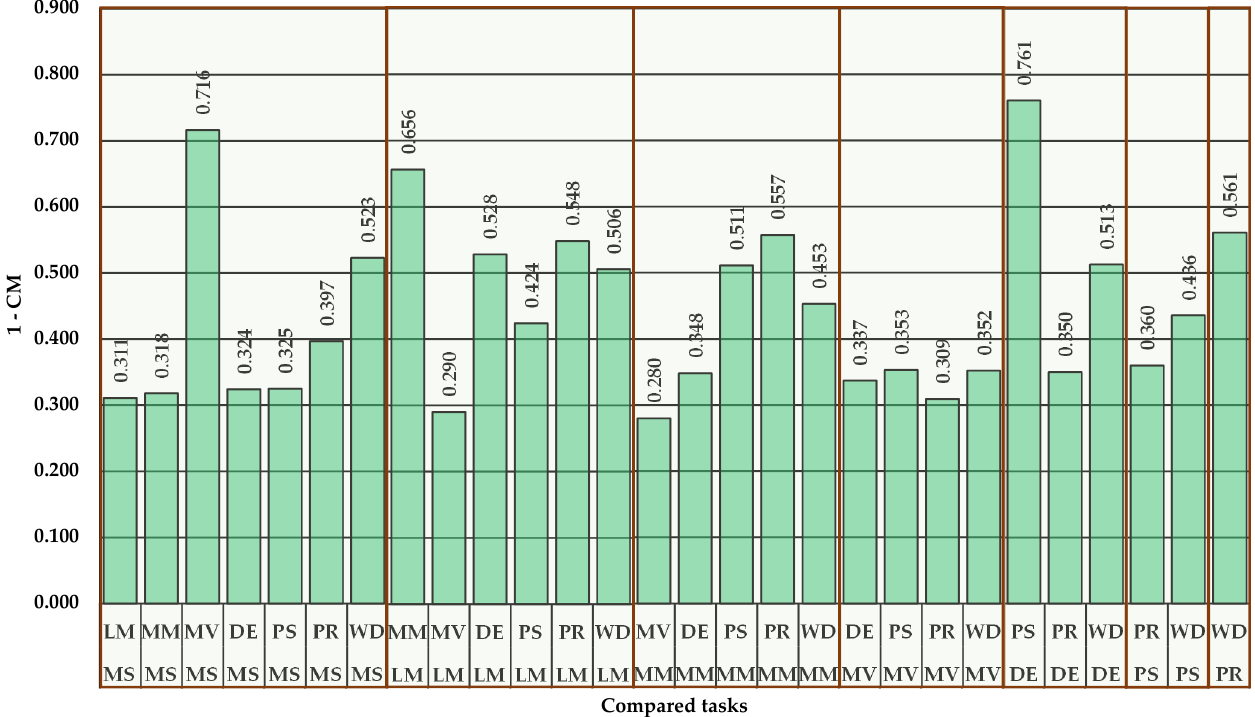
Figure 4. Similarity of tasks by the frequency of action categories. Last, but not least, MS was rather dissimilar to MM (1 − CM = 0.318) and PS (1 − CM = 0.325), while PS was more similar to MM (1 − CM = 0.511) but not to the same extent as the similarity between MM and LM. Form this point of view, at least